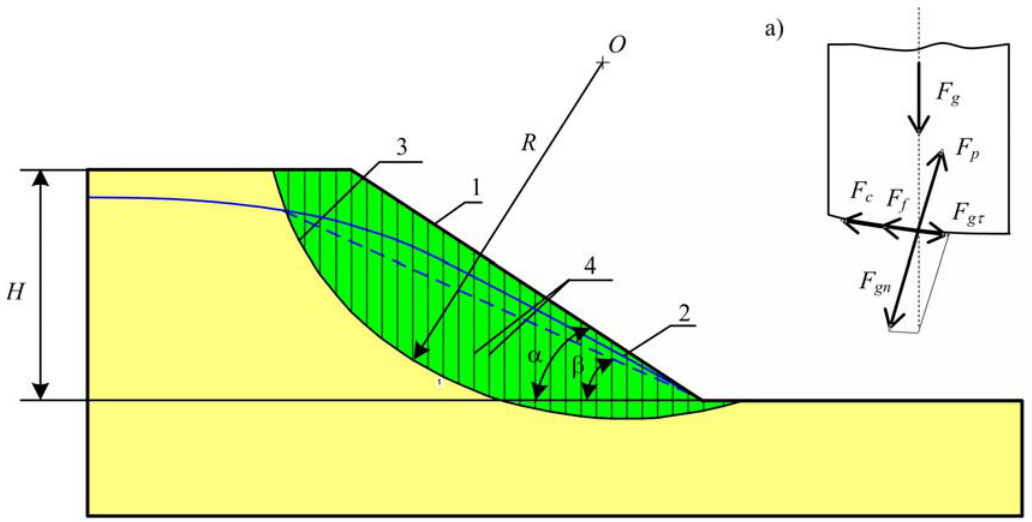
Fig. 4. Scheme of slope dimensions and force vectors for computation of slope stability by slice method: a is slice bottom; 1 is slope profile; 2 is ground water depression surface profile; 3 is supposed slip surface profile; 4 is the limits of a single slice